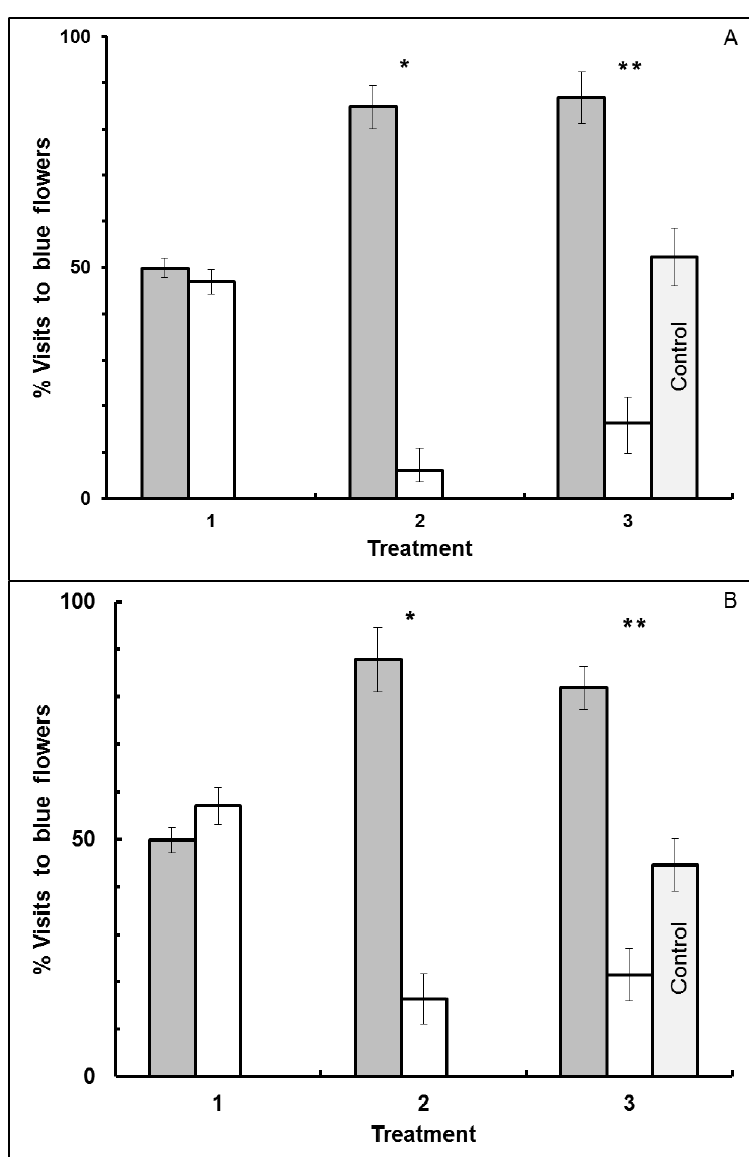
Figure 5. Visitation by bees to blue-white dimorphic flower patches in Experiment III. Reward odor, site location and time differed between morning and afternoon flower patches. Percentage of blue flowers visited is presented for blue forager-type bees in Panel ( A ) (N = 14 bees), and for white forager-type bees in Panel ( B ) (N = 15 bees). Error bars indicate ±1 SE. Bar color is by flower color offering the higher molar sucrose reward in Treatment 2: gray bars = bees given the higher molar reward in blue flowers, and white bars = bees given the higher molar reward in white flowers. Treatment 1: morning patch, flat flowers with clove scent, with both blue and white flowers offering the same reward. Treatment 2: morning patch, flat flowers with clove scent, with reward difference between blue and white flowers. Treatment 3: afternoon patch, flat flowers with peppermint scent, with both blue and white flowers offering the same reward. Control represents bees that had never visited the morning patch, and thus never experienced Treatments 1 and 2 (N = 23 bees). * significant difference ( p <